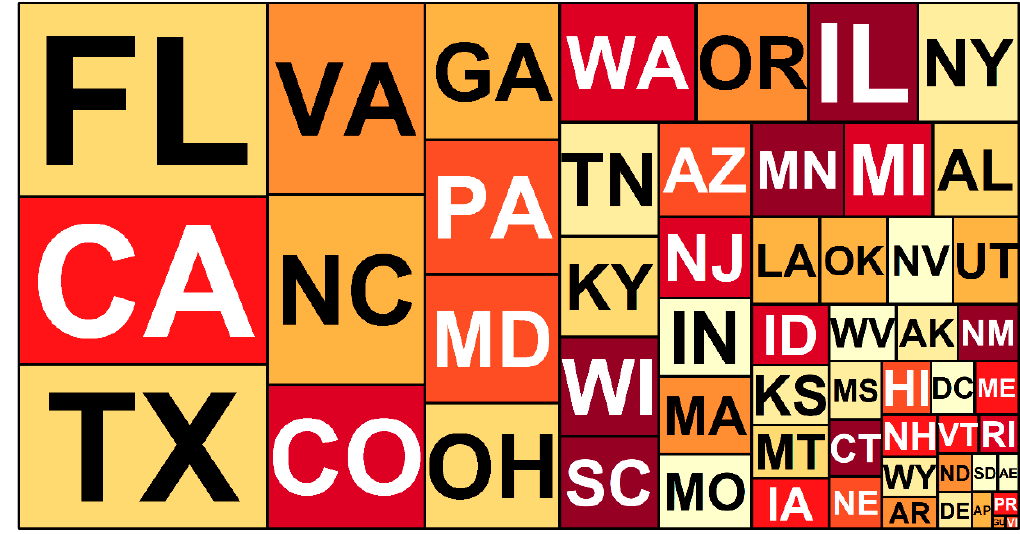
Figure 3. The states ranked by the number of GISPs.